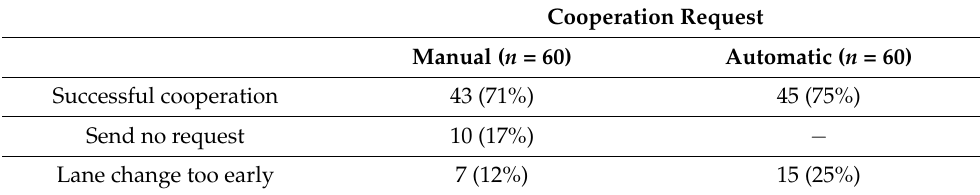
Table 2. Summary of reasons for unsuccessful overtaking